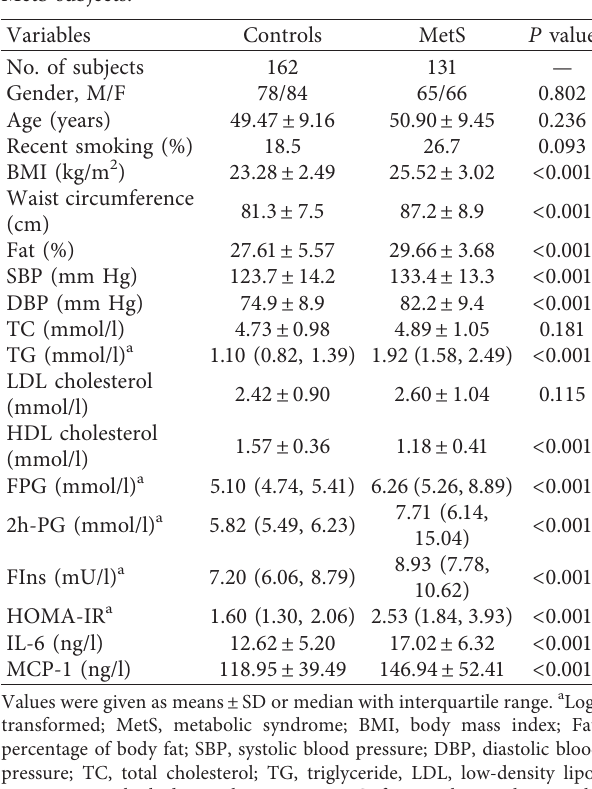
Table 1: Clinical and biochemical characteristics of controls and MetS